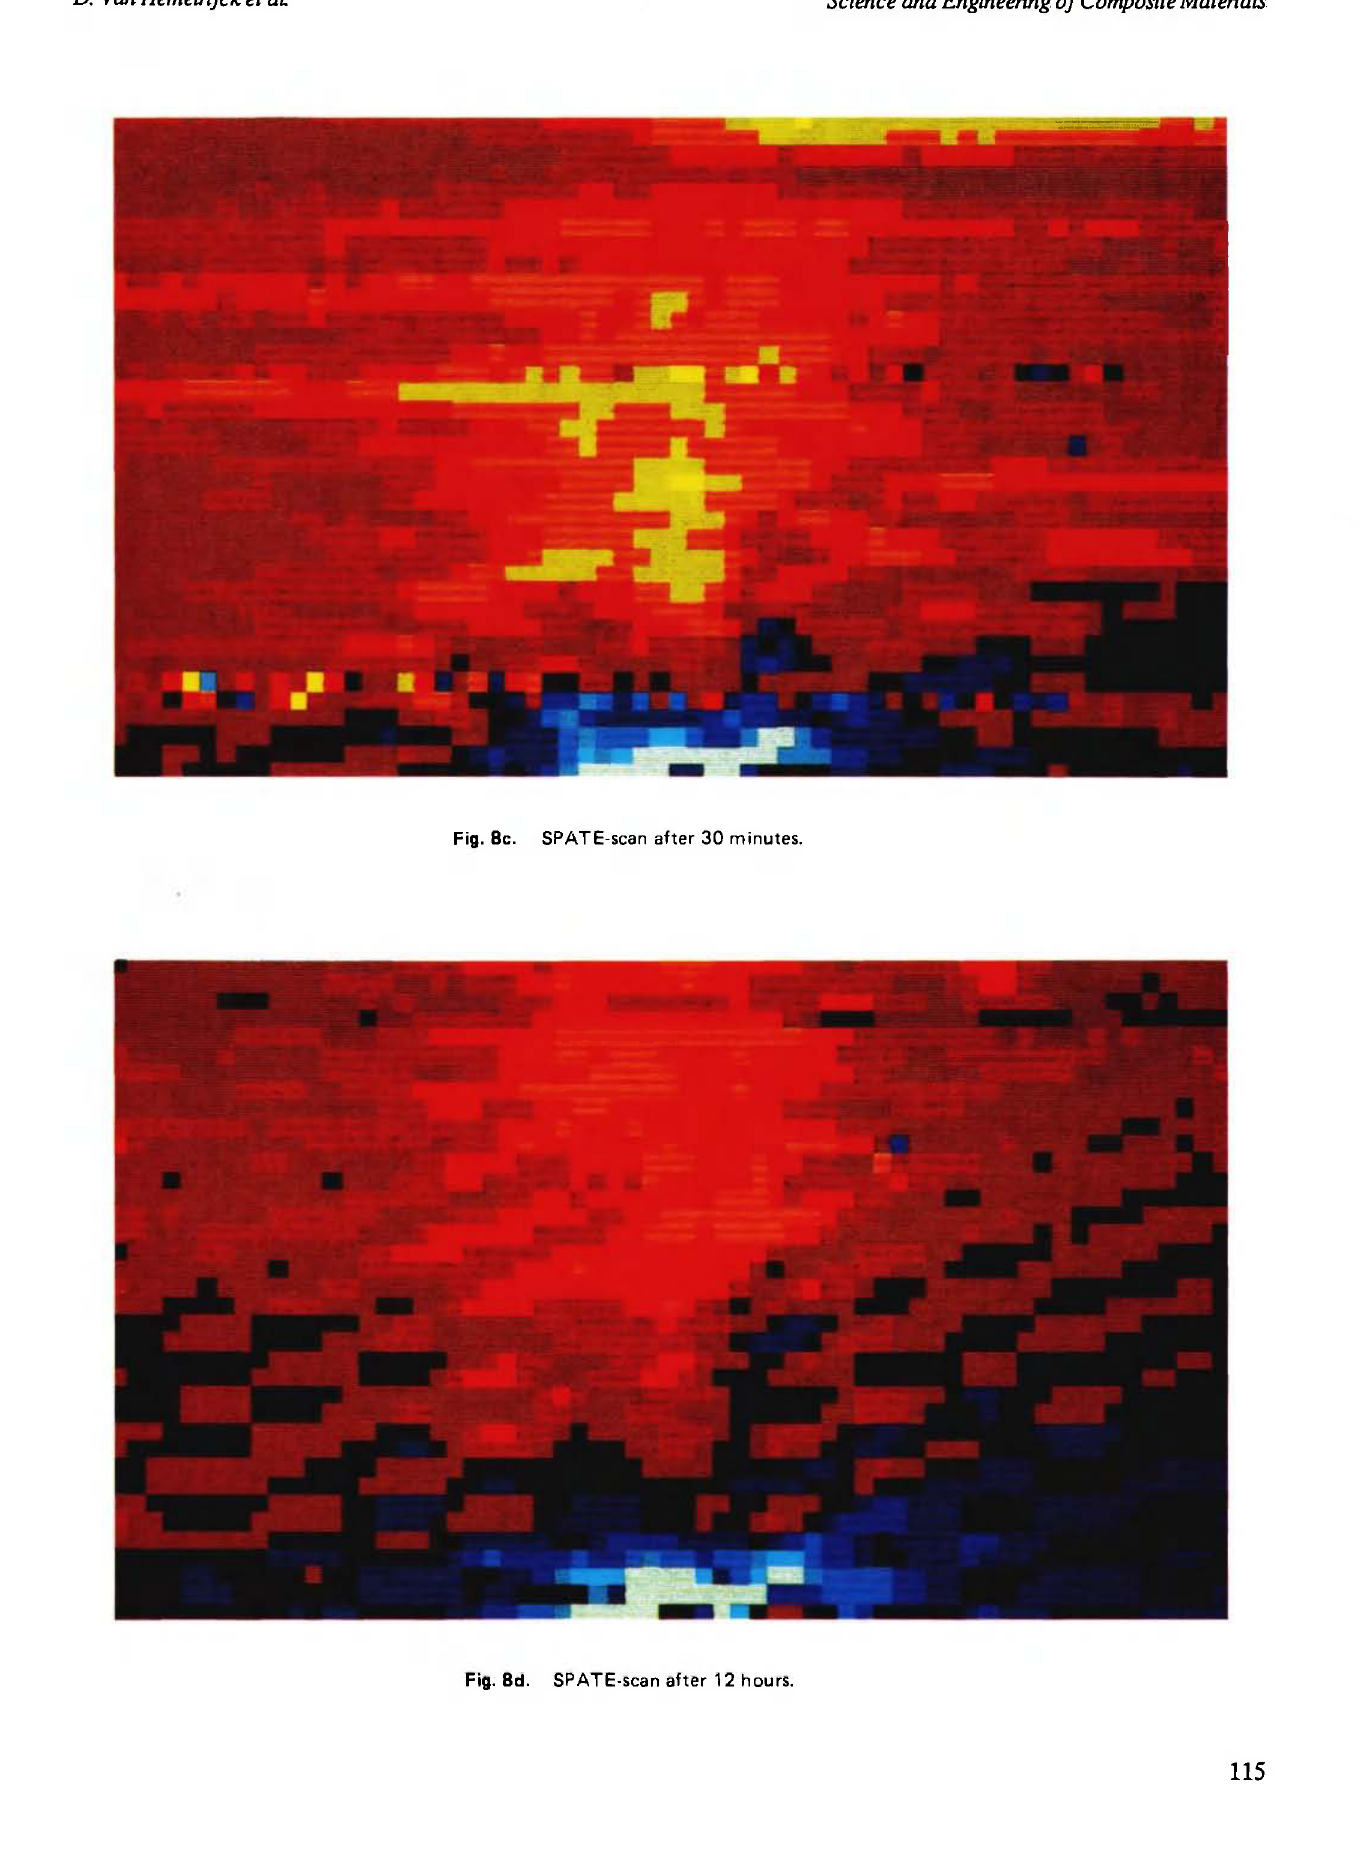
Fig. 8c. SPATE-scan after 30 minutes.